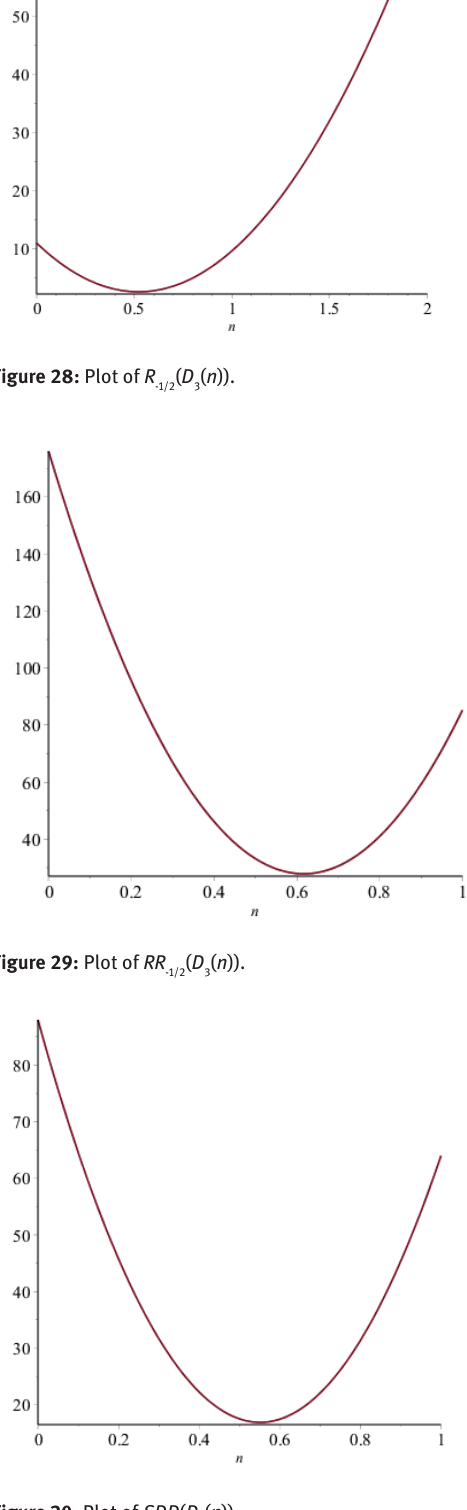
Figure 30: Plot of SDD ( D